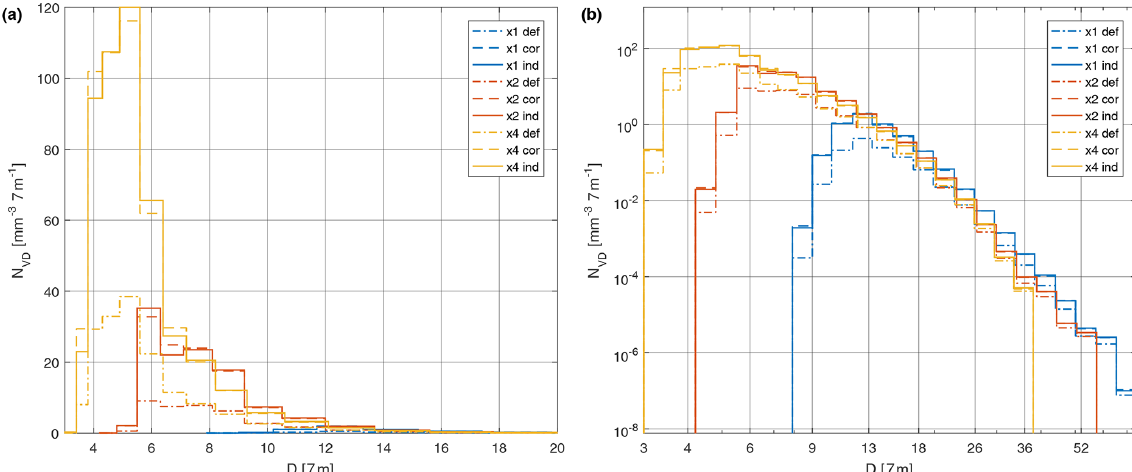
Figure 7. Comparison of the droplet size distributions obtained with three methods – default (def), corrected (cor) and individual (ind) – for the three measurement series obtained with different lens magnification settings. The same data are plotted on (a) linear and (b) logarithmic